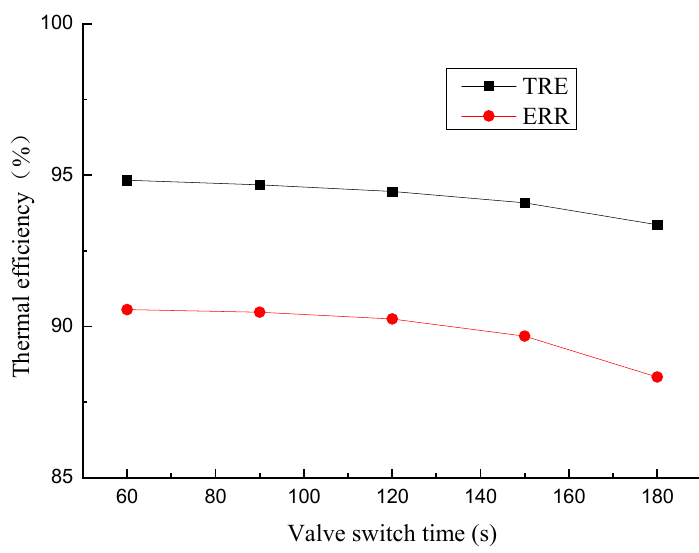
Figure 9. Effect of valve switch time on heat transfer efficiencies.